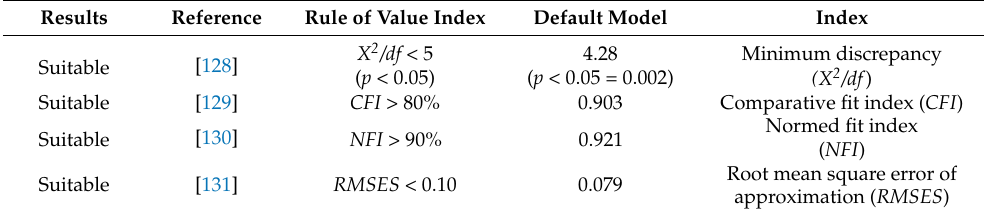
Table 4. Fit Model.